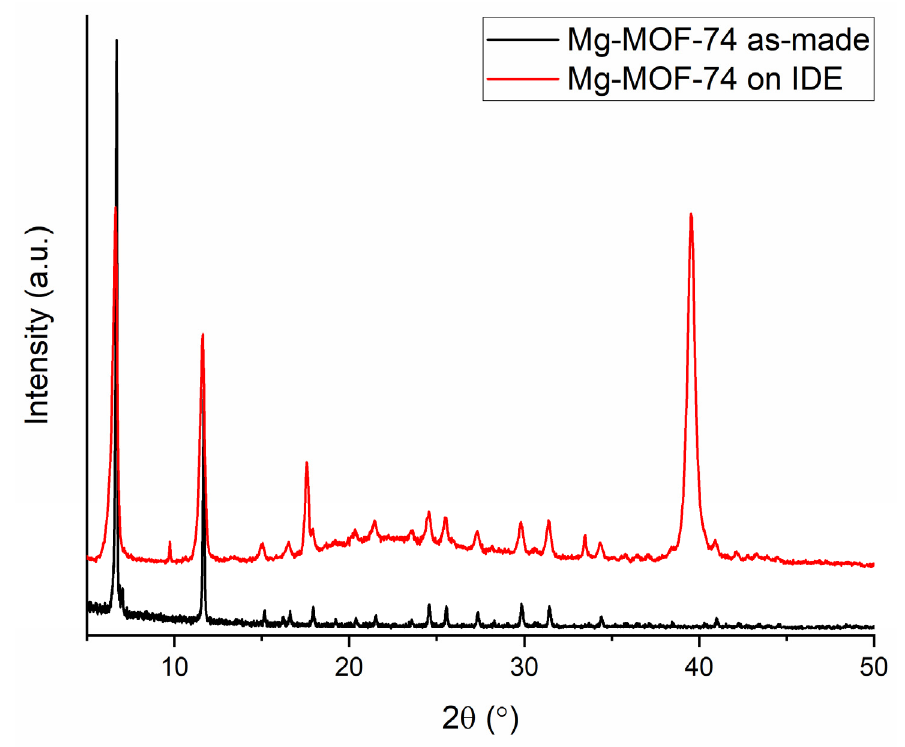
Figure 4. Powder X-ray diffraction patterns for bulk Mg-MOF-74 (black) and the Mg-MOF-74 grown on IDE (red). The peak at 40 ◦ 2 θ corresponds to Pt, and the broad diffuse hump at 15–30 ◦ 2 θ corresponds to glass. The peak at 17.5 ◦ 2 θ corresponds to DOBDC linker, that is later washed out with water.